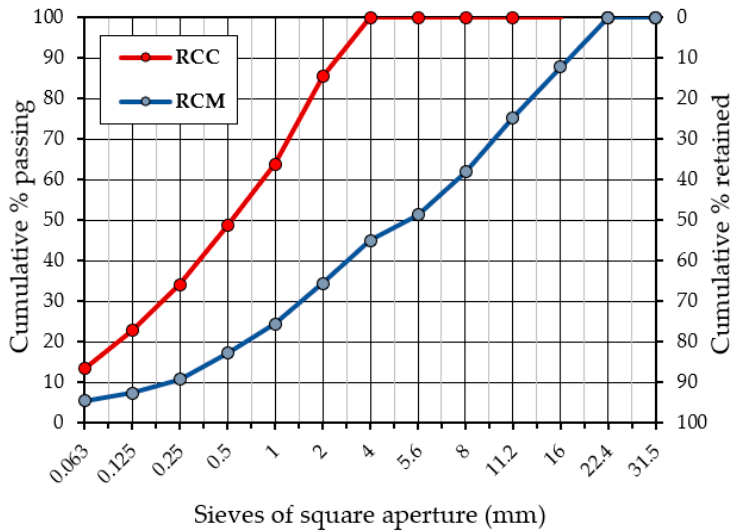
Figure 2. Particle size distribution of reclaimed cement material (RCM) and reclaimed cement concrete (RCC).